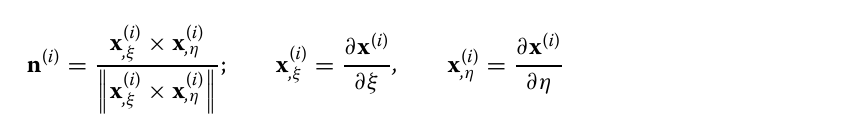
Fig. 1 Sketch of two deformable solids getting in